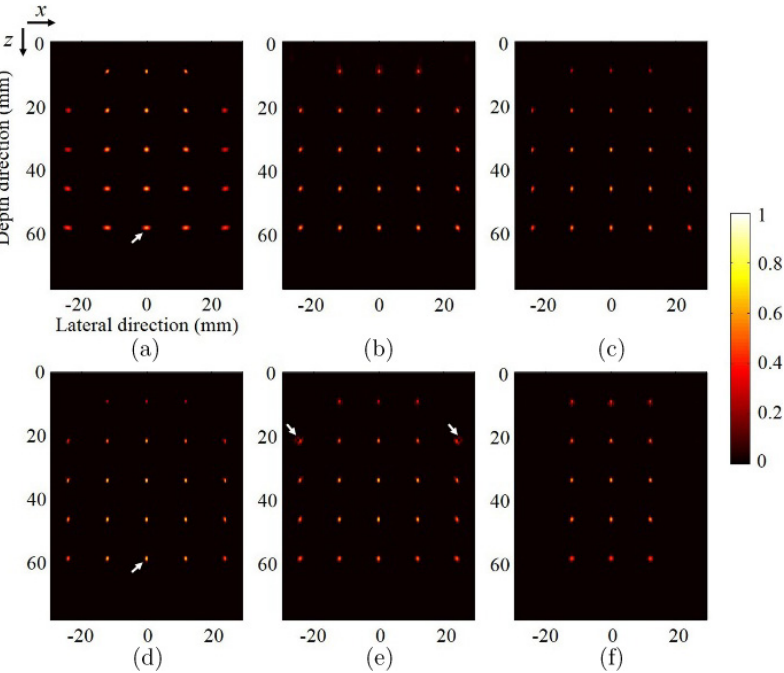
Fig. 5. Numerical simulation results of enhanced resolution in synthetic aperture PAT. PA images recovered from single aperture with (a) 128 and (b) 128 (cid:3) 3 elements. (c) – (f) PA images recovered from aperture orientations of 45 (cid:1) , 60 (cid:1) , 75 (cid:1) , and 90 (cid:1) ,